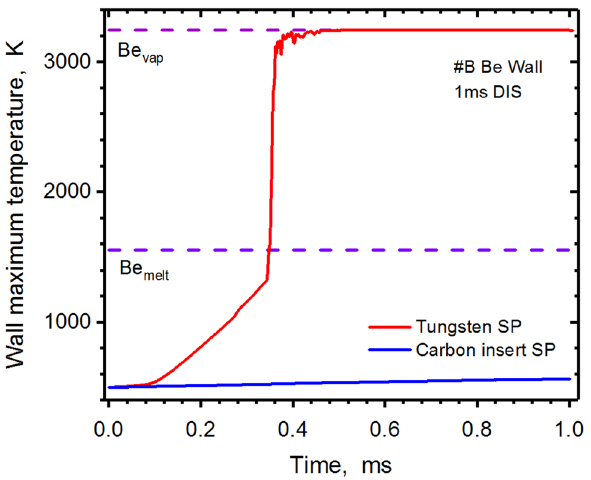
Figure 8. HEIGHTS simulation of PFC transient response: Beryllium wall (#B) surface maximum temperature during a 1.0 ms disruption, see Fig. 1b for surfaces location. Tungsten SP (red), carbon insert at SP (blue). The images were prepared using OriginPro V2020.